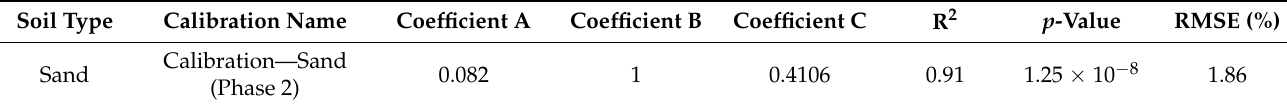
Table 7. Clay Laboratory calibration—Volumetric water content from Gravimetric method.